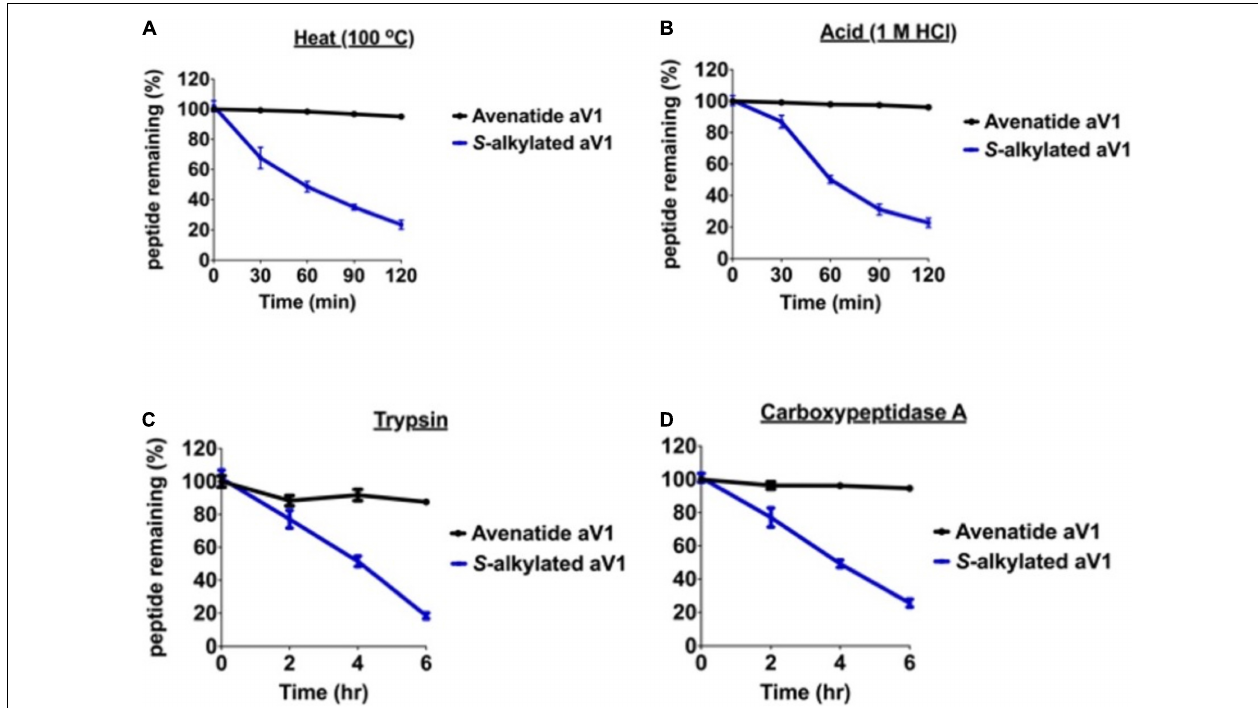
FIGURE 5 | Stability comparison of avenatide aV1 and S -alkylated aV1 (iodoacetamido-) under (A) heat (95 ◦ C), (B) acid (1M HCl), (C) trypsin, and (D) carboxypeptidase A treatment as analyzed by RP-HPLC ( n = 3).